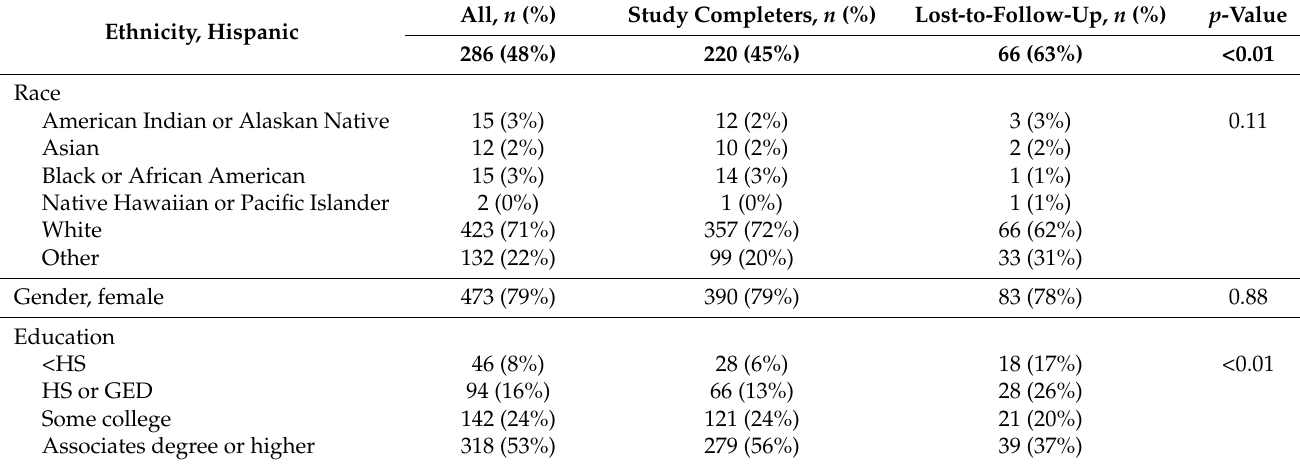
Table 1. Patient baseline characteristics and testing results by follow-up status (N =